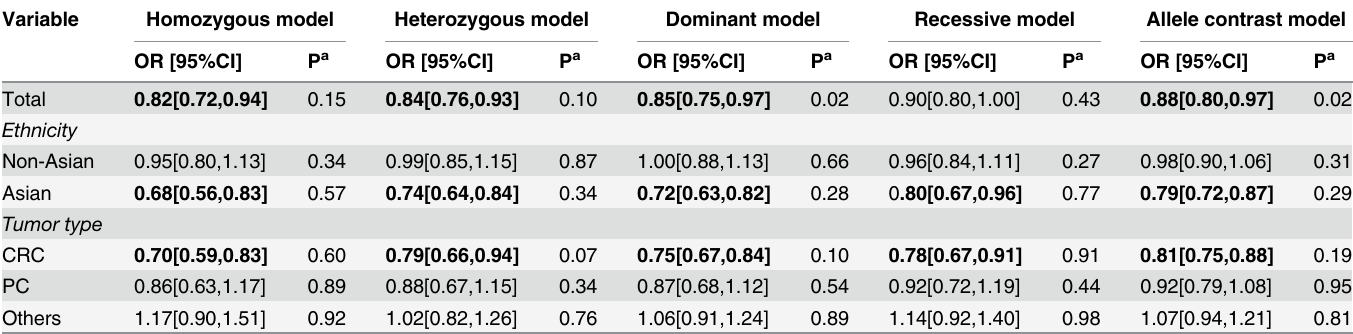
Table 4. Overall and subgroup analysis of the ADIPOR1 rs1342387(G/A)polymorphism and cancer risk.